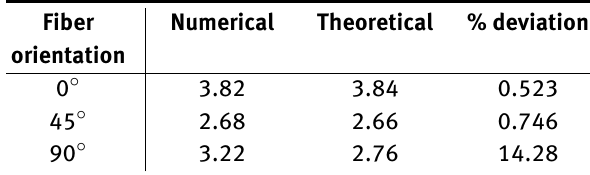
Table 6: Stress concentration factors for different fiber